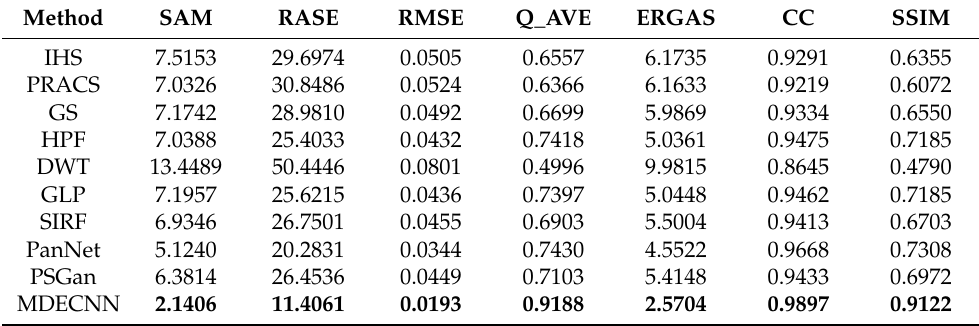
Table 5. Quantitative assessment of the GeoEye-1 dataset shown in Figure 10. The best performance is shown in bold.